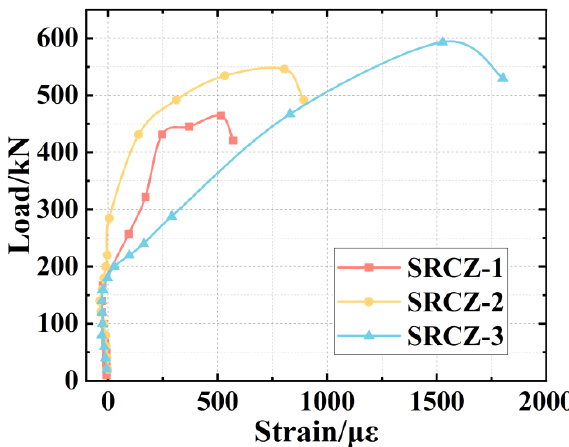
Figure 11. Load – Strain Curve of the Hooped Reinforcement. Figure 11. Load–Strain Curve of the Hooped Reinforcement.